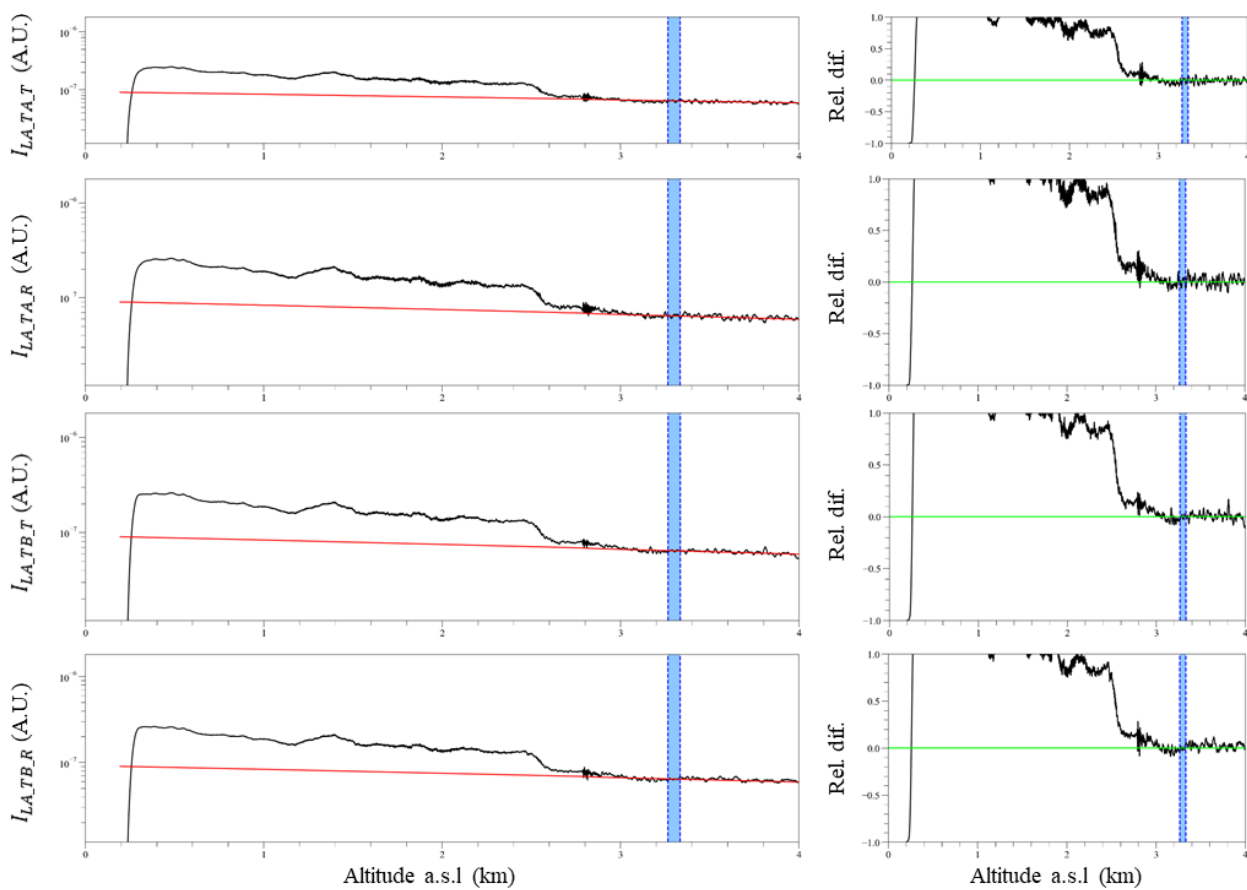
Figure 15. First column: the Rayleigh fit (Freudenthaler et al., 2018) of the averaged cloud-free signals in Fig. 13. Second column: the corresponding differences of the attenuated backscatter signals with the attenuated backscatter signals of the molecular atmosphere. The blue shaded area marks the reference height used for performing the Rayleigh